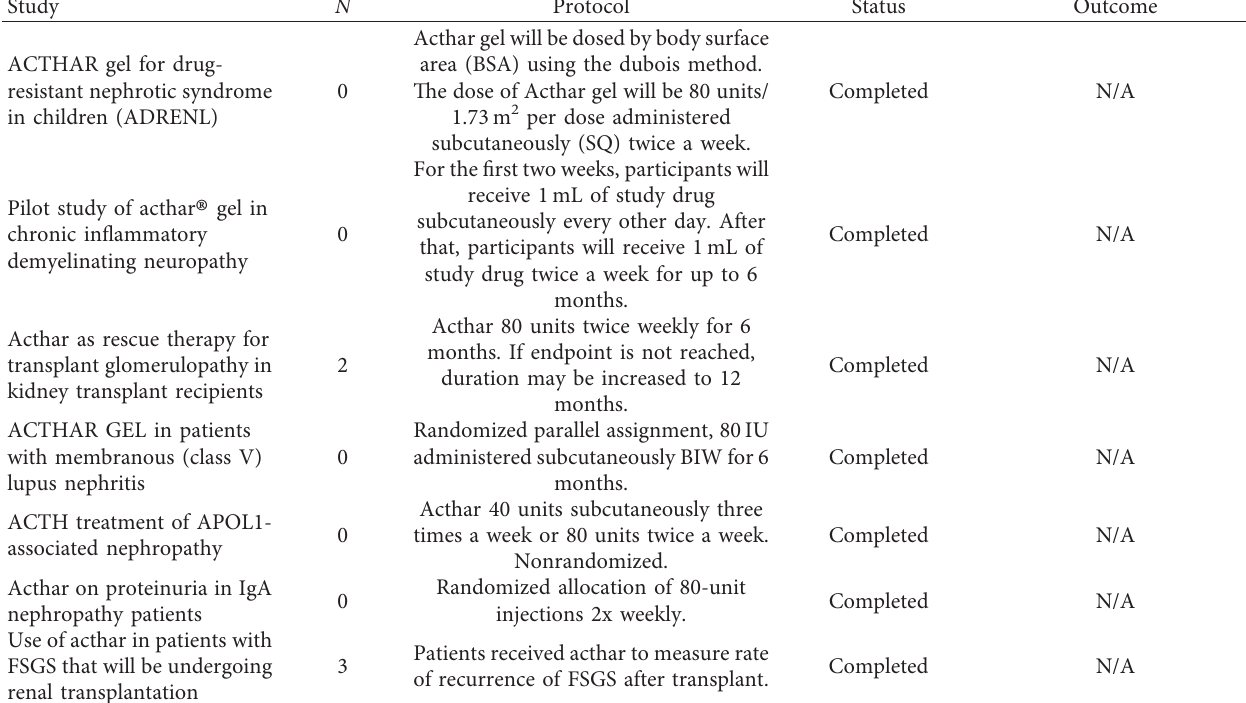
Table 2: Summary of clinical trials found on